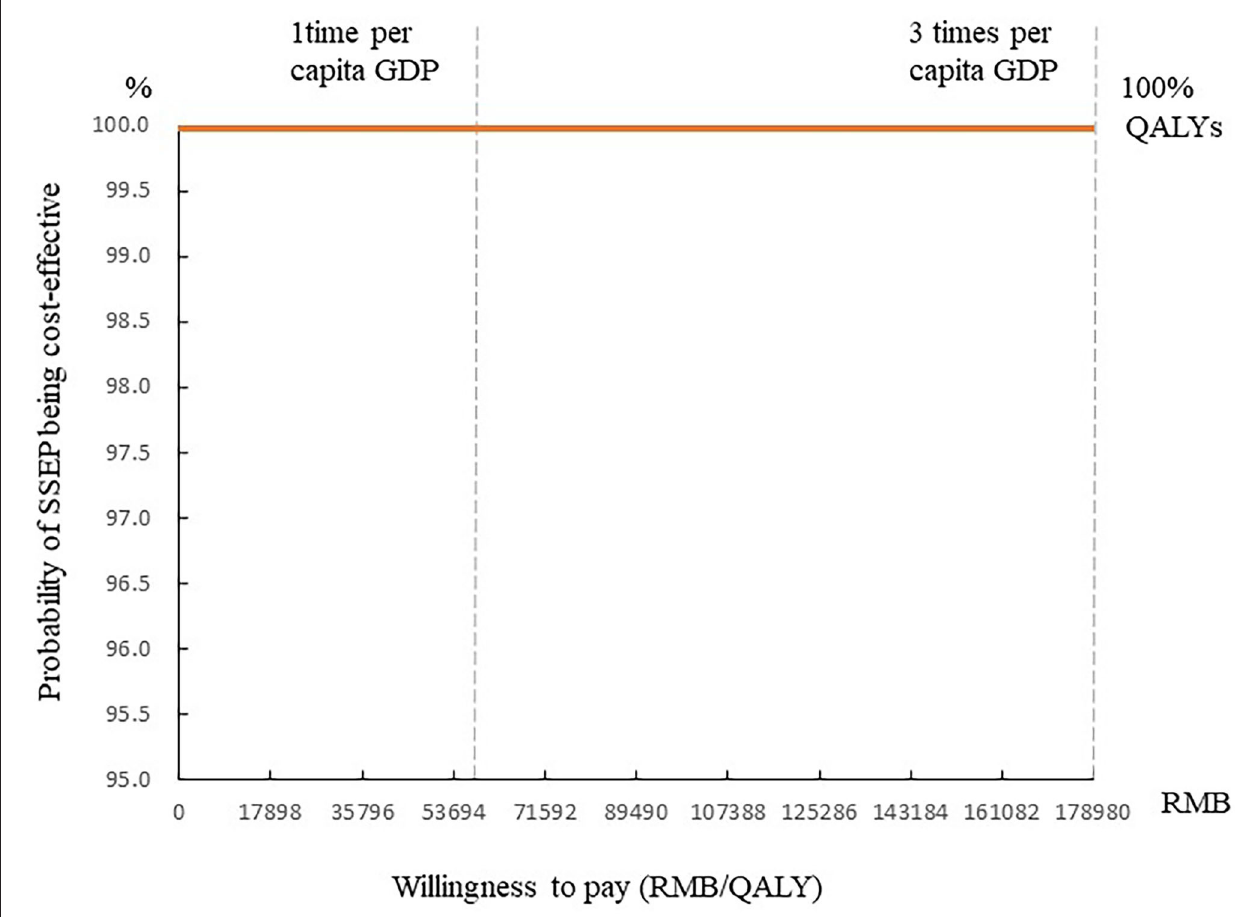
FIGURE 3 | The cost-effectiveness acceptability curve of the SSEP. GDP, gross domestic product; QALYs, quality-adjusted